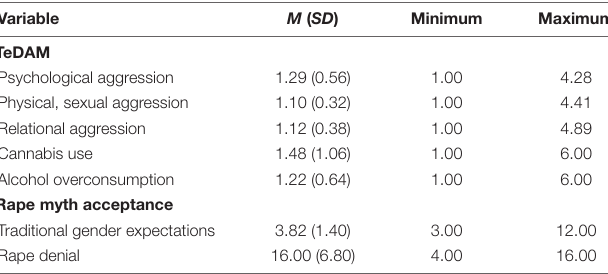
TABLE 7 | Descriptive statistics of study variables for the overall sample.